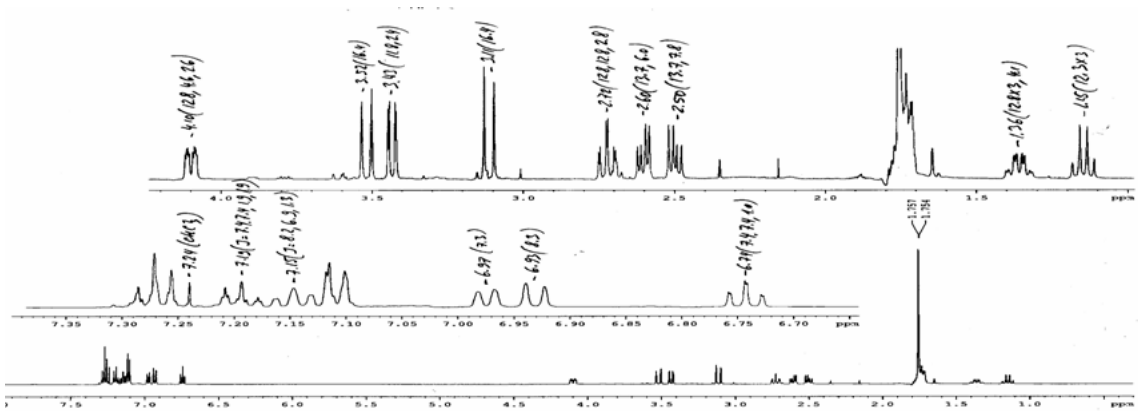
Figure 1. The 1 H-NMR spectrum of compounds